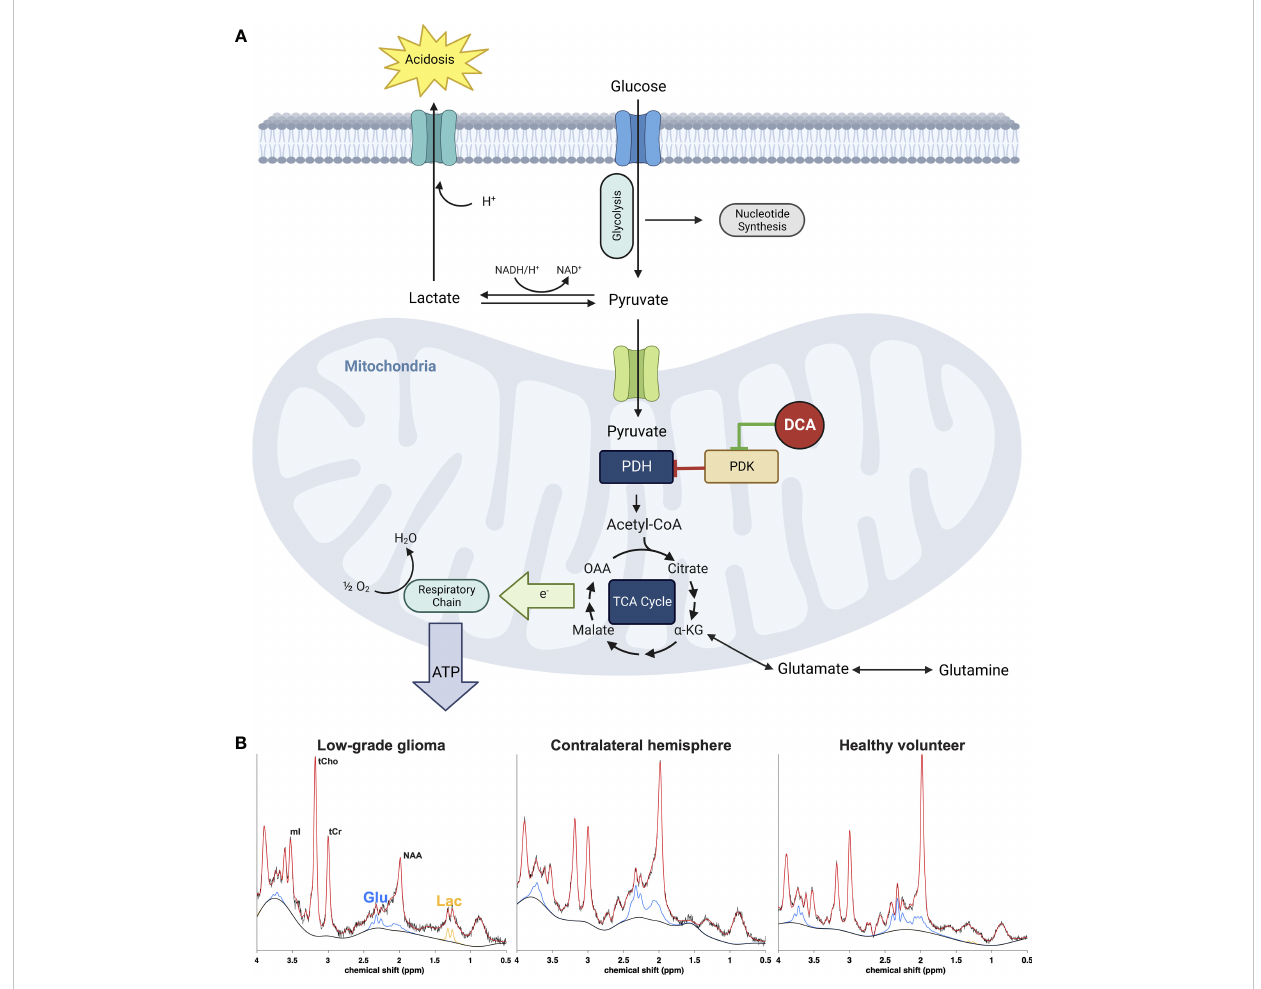
FIGURE 1 (A) Effect of DCA on metabolic pathways of cancer cells. Inhibition of the pyruvate dehydrogenase (PDH) complex by pyruvate dehydrogenase kinase (PDK) is responsible for the aerobic glycolysis observed in cancer, also known as the Warburg phenomenon. Accumulation of cytosolic pyruvate is converted to lactate which contributes to the acidi fi cation of the extracellular environment or utilized for anabolic processes necessary for cancer cell growth and proliferation. DCA inhibits PDK, activating the PDH complex and thus forcing the cancer cell to allow pyruvate to enter the tricarboxylic acid cycle and eventually terminal oxidation to generate ATP and restore the apoptotic machinery of the mitochondrion. The metabolic consequence is a rapid reduction of extra and intracellular lactate as well as increase of glutamate as the cell no longer has to rely on the latter as an alternative carbon source for the TCA cycle. (B) Representative 1H-MRS spectra from a low-grade glioma (left) normal appearing brain from the same patient (middle) and healthy normal volunteer (right). The signals from glutamate (Glu, blue) and lactate (Lac, orange) can be monitored after DCA administration to assess ef fi cacy of drug